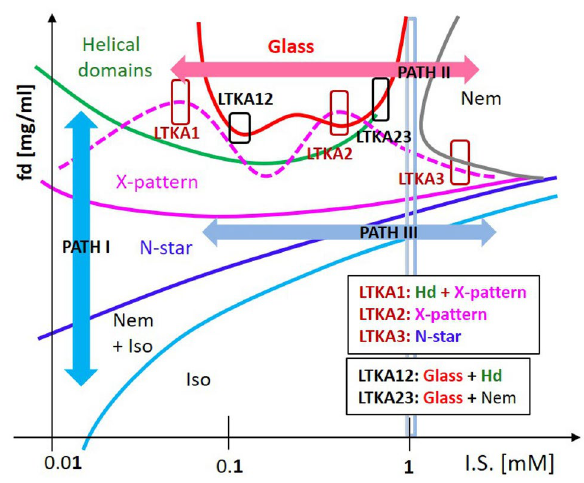
Figure 10. Simplified equilibrium phase diagram of several phases for chiral-nematic mesophases, chiral- mesophases, and the glass states, as well as with different phase boundaries. The dynamic pathways are shown as Path I, Path II, and Path III in logarithmic scales of ionic strength: The phases of each LTKA are expressed in the arrangement of orientation textures in the phase diagram (see also Fig.